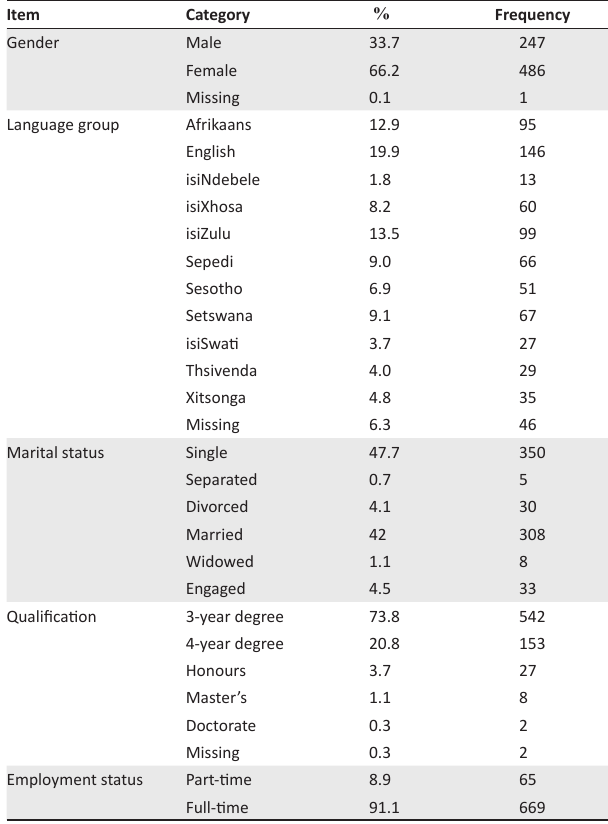
TABLE 1: Characteristics of participants in the sample ( n =